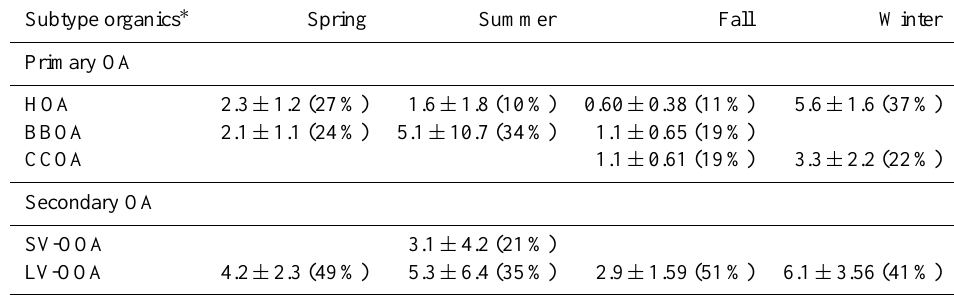
Table 3. Seasonal averaged mass concentrations (µgm − 3 ) and standard deviation (in parentheses) of specific types of organic aerosols from positive matrix factorization